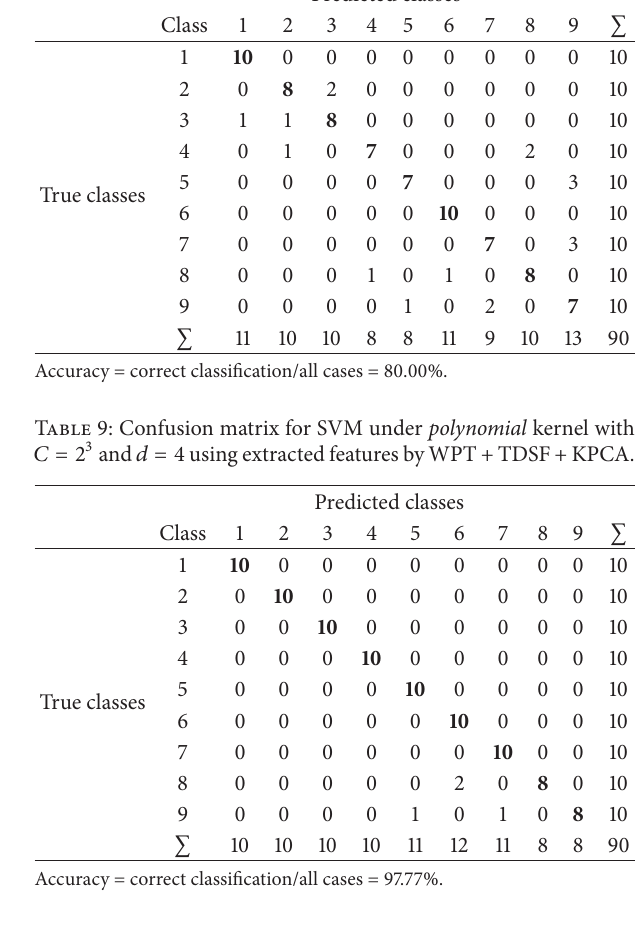
Table 7: Confusion matrix for SVM under polynomial kernel with 𝐶 = 2 3 and 𝑑 = 4 without feature extraction. Predicted